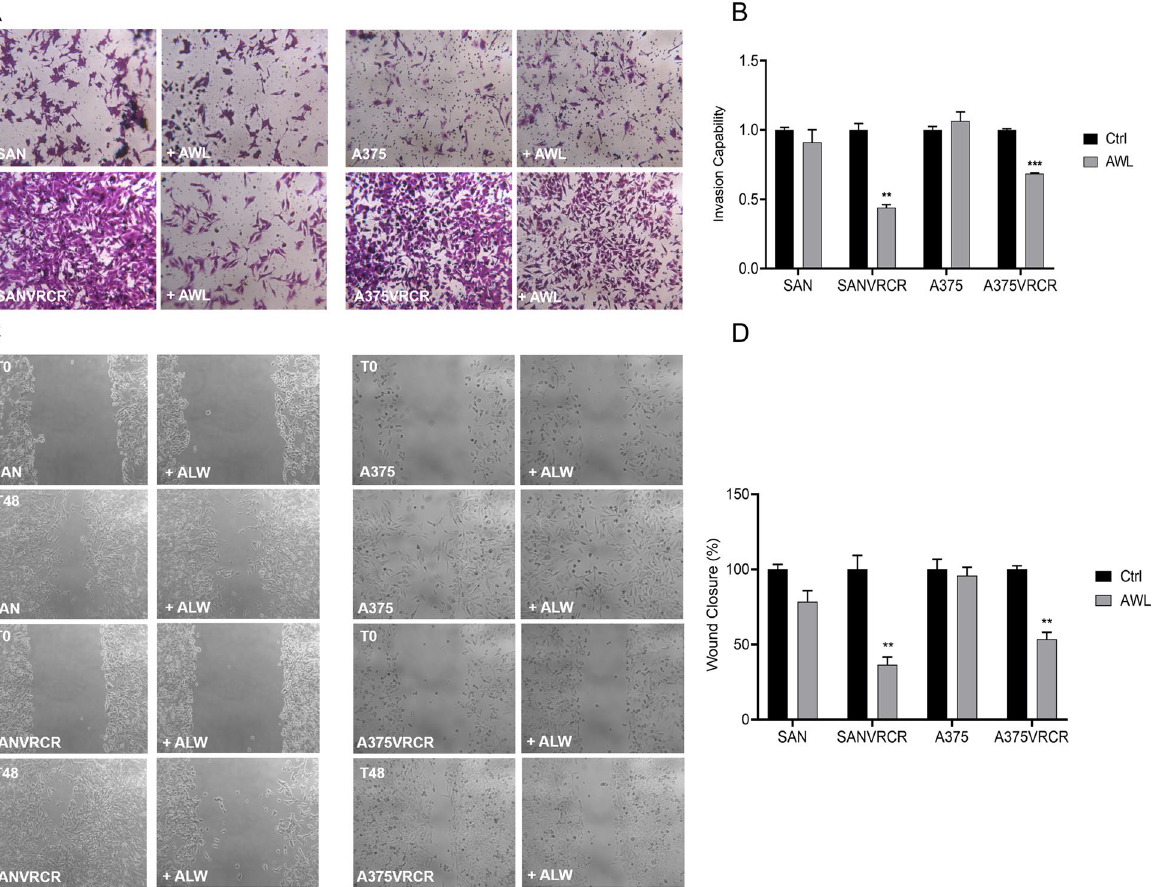
Fig. 4 Effects of ALW-II-41-27 treatment on invasion and migration in vemurafenib and/or cobimetinib-resistant melanoma cell lines. Parental and resistant cell lines were treated with 0,5 µM of ALW-II-41-27for 48 h. A Cell invasion ability was evaluated by the Transwell invasion assay. B Graph bar showing the invasion capability of melanoma cancer cell lines untreated and after treatment. C Cell migration capability was measured by the wound-healing assay. D Graph bar showing the migration capability of melanoma cancer cell lines untreated and after treatment. **: P < 0.001;